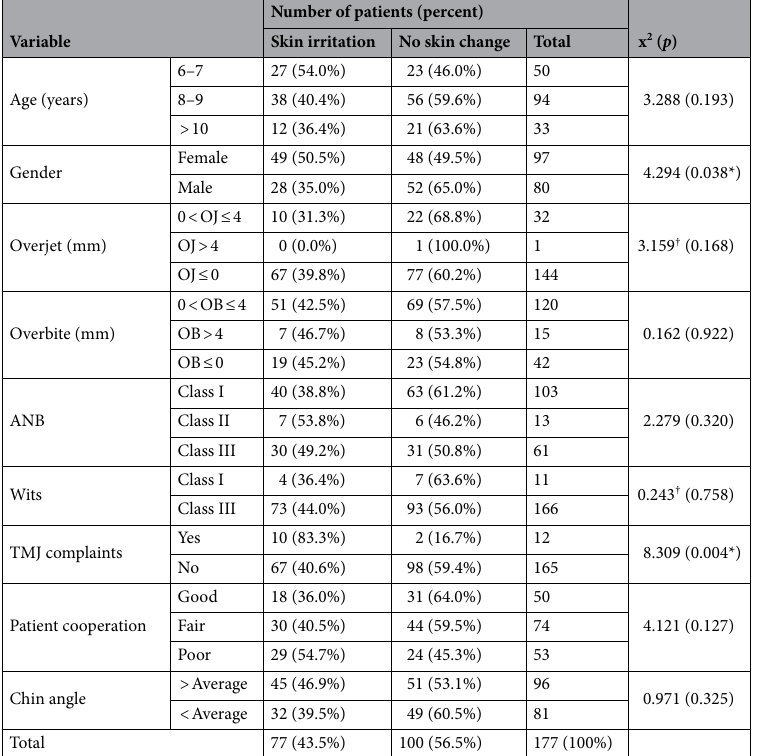
Table 3. The proportion of patients with skin irritation according to the variables. * p < .05. † Fisher’s exact